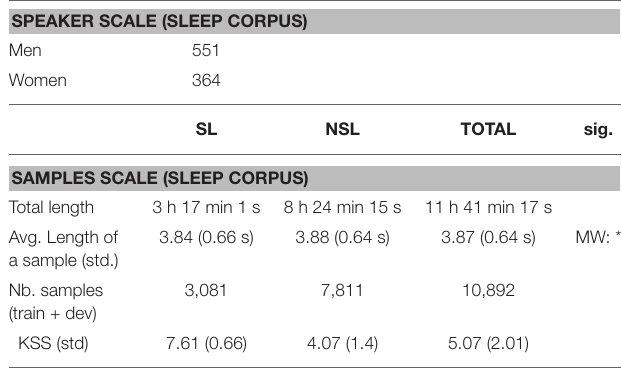
TABLE 2 | Global statistics of the train and development subsets of the SLEEP